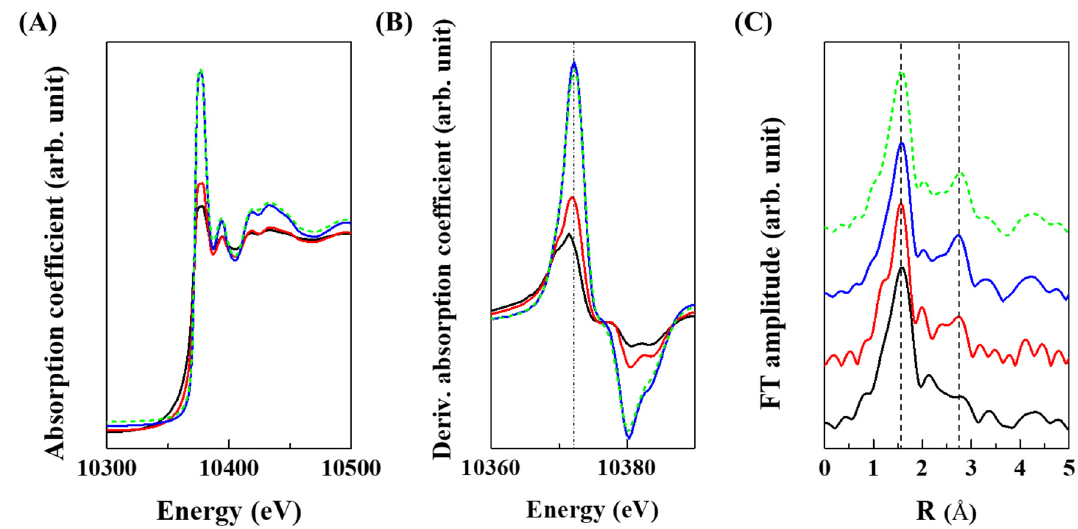
Figure 5. Ga k-edge ( A ) X-ray absorption near-edge structure, ( B ) derived X-ray absorption near-edge spectra, and ( C ) Fourier-transform extended X-ray absorption fine structure (FT-EXAFS) spectra of Ga@LDH-0.5 (black line), Ga@LDH-1 (red line), Ga@LDH-24 (blue line), and MgGa-LDH (green dots).